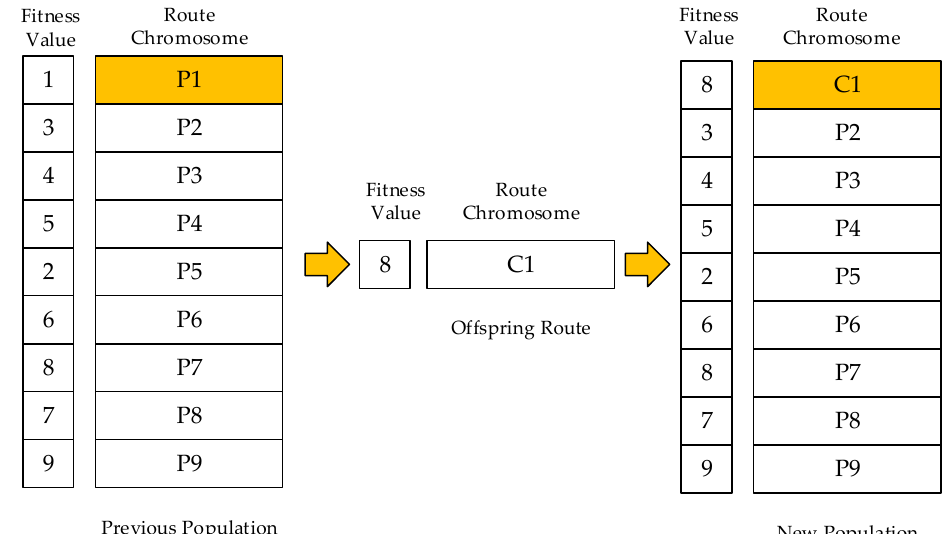
Figure 10. Fitness based selection for generating a new population.